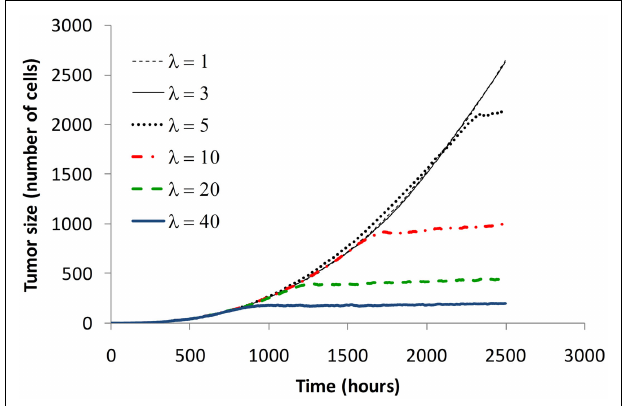
FIGURE 1 | Effect of nutrient consumption on tumor growth rate. The figure shows typical growth curves obtained by varying nutrient consumption rate λ . Increased nutrient consumption rates lead to smaller tumors. For very low nutrient consumption rate, tumor growth does not